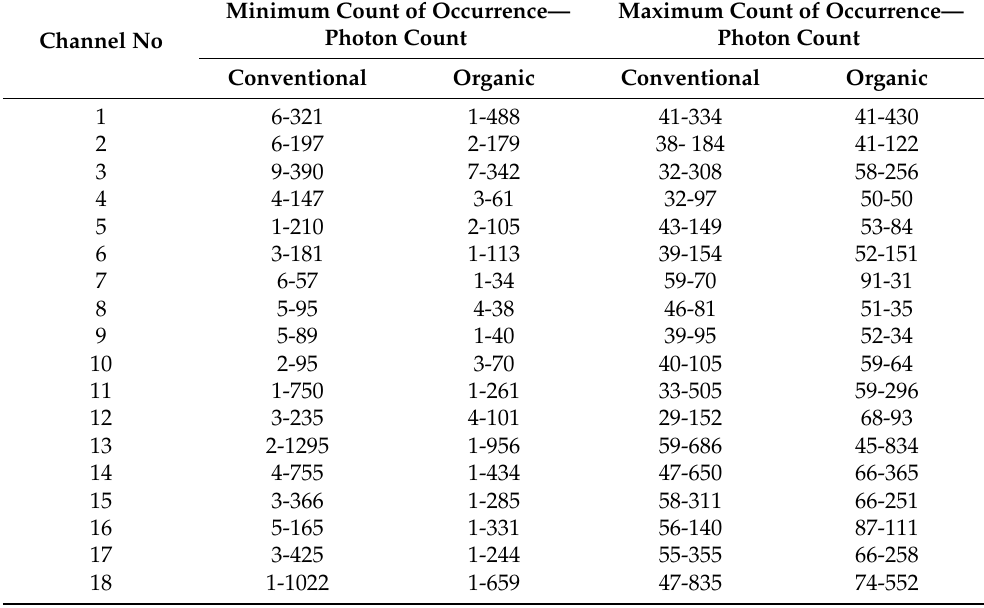
Table 5. Eighteen-channel photon count distribution and its number of occurrences for conventional and organic